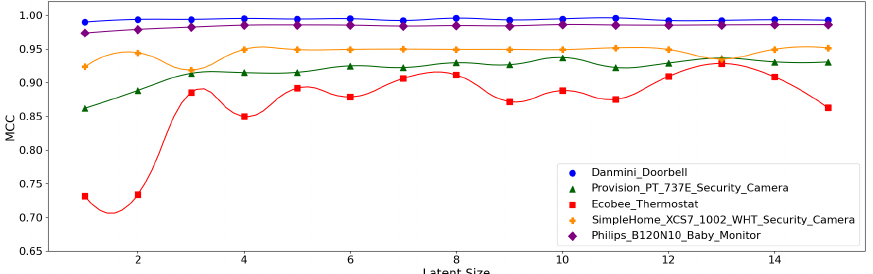
Figure 12. MCC per device for the N-BaIoT dataset when the (5,32) model is